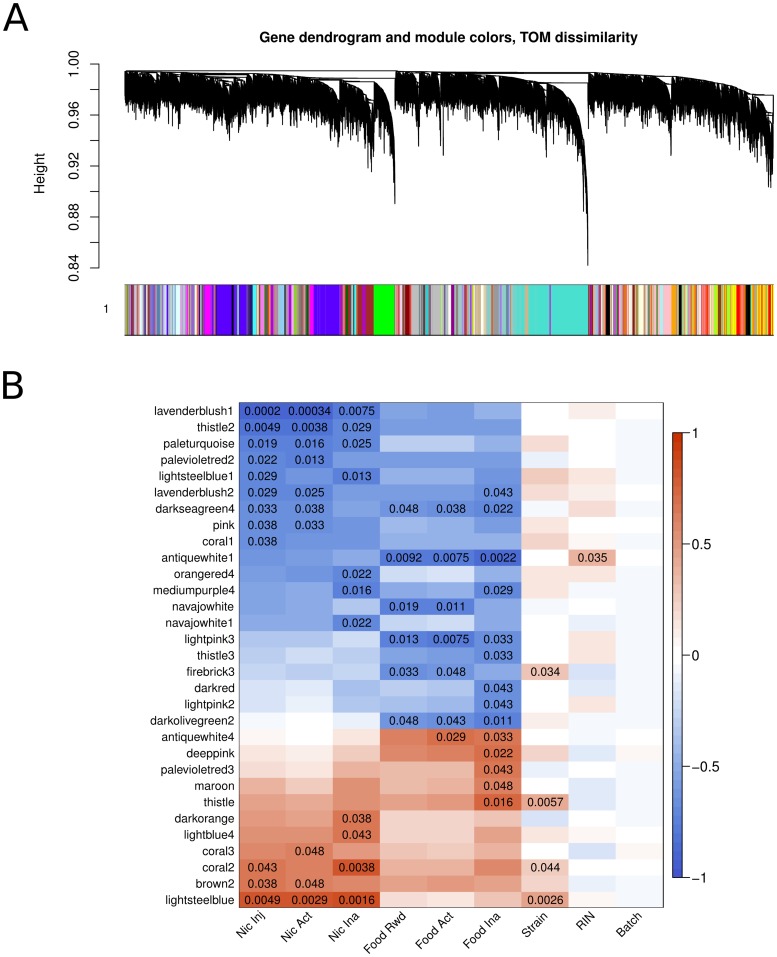
WGCNA detected networks of correlated genes.(A) Weighted Gene Correlation Network Analysis (WGCNA) was applied to 12,639 genes. A total of 127 modules were identified in AcbS. Each module was named after a unique color assigned by the algorithm. Genes within each module were strongly correlated with each other across all the samples. (B) Modules significantly associated with any of the listed traits are plotted. Twelve modules were associated with stable levels of nicotine intake during last 3 d of SA (when nicotine intakes were stable). Of the 12 modules, nine were negatively correlated with nicotine intake, suggesting their expression in the AcbS protect against voluntary nicotine intake in adolescent rodents.